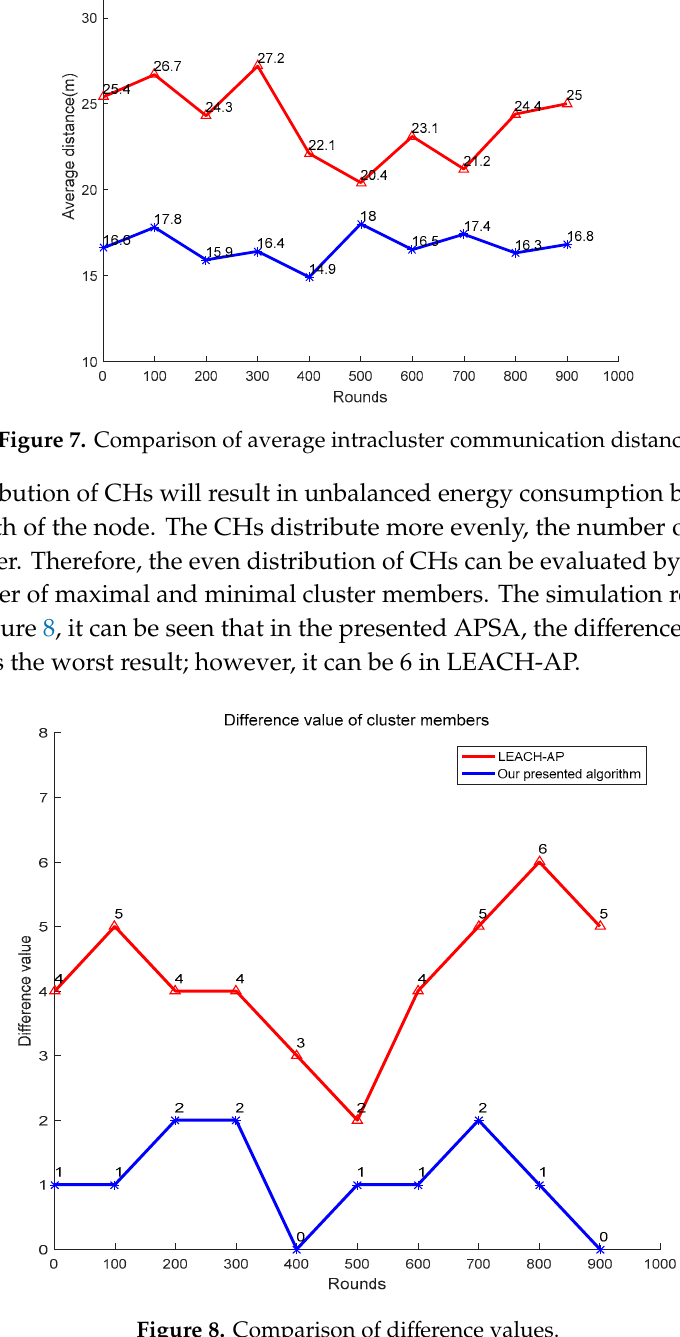
ff erence Figure 8. Comparison of difference values. Figure 8. Comparison of di Figure 8. Comparison of difference values.